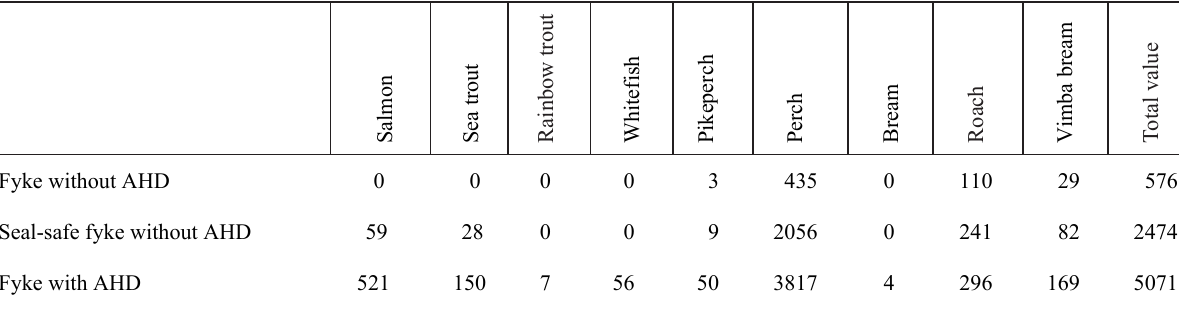
Table 4. Catch (kg) and its value (euros) of three fyke nets in September–October 2013 in locality B